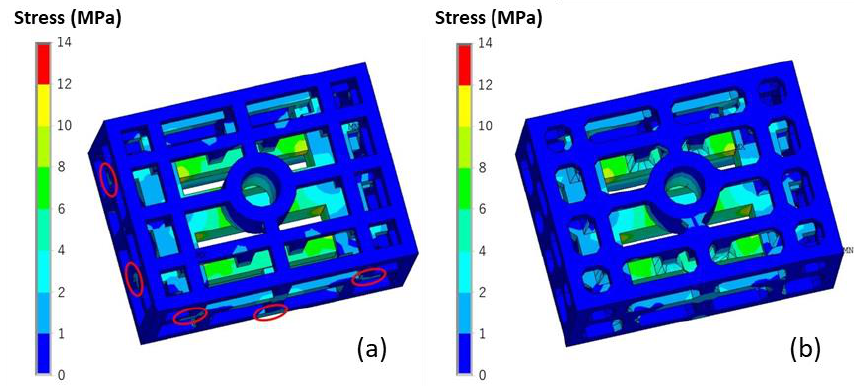
Figure 24. Comparison of the von Mises stress of the skeletal sand mold at shakeout (a) without filleting and (b) with filleting.